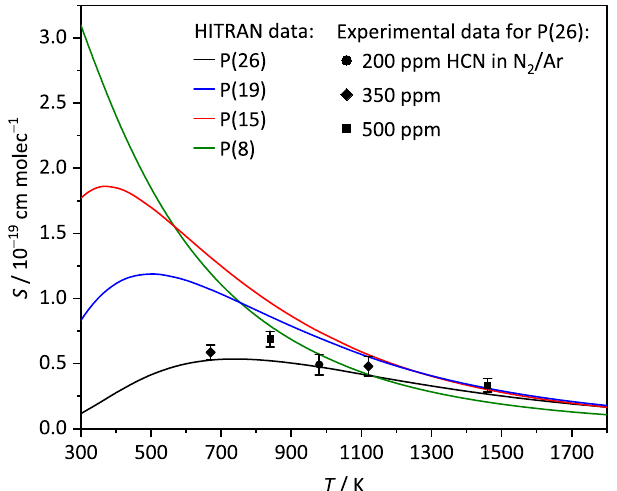
Figure 1. Temperature-dependent linestrengths S for several rovibrational transitions in the P-branch of the ν 1 band of HCN. HITRAN database [30] predictions (curves) are compared to experimental data obtained for the P(26) transition (symbols).